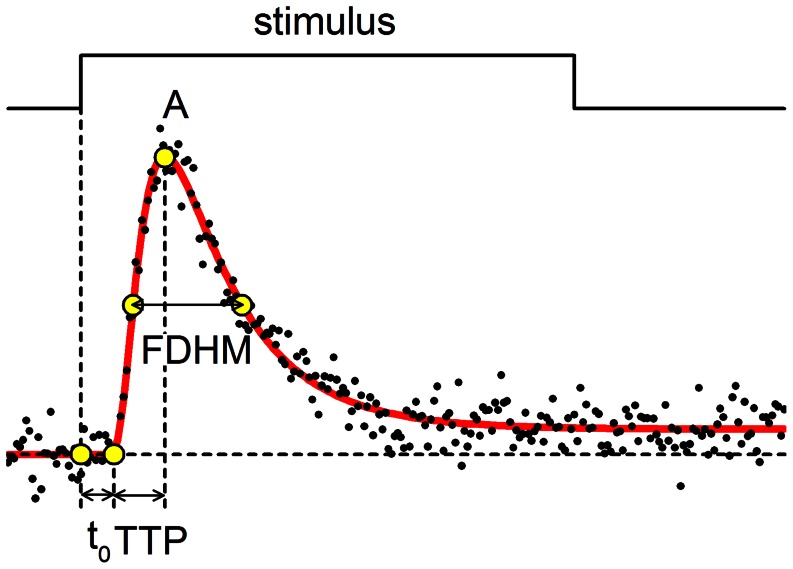
Description of calcium spikes.Voltage stimulus from −50 to 0 mV is shown in the top panel. The extracted time course of a calcium spike (black dots) was fitted with the theoretical function (red line, Eq. 1). The latency t0 was estimated by fitting, and the descriptors were estimated numerically as illustrated. A – peak amplitude, t0–latency, TTP – time to peak, FDHM – full duration at half maximum.